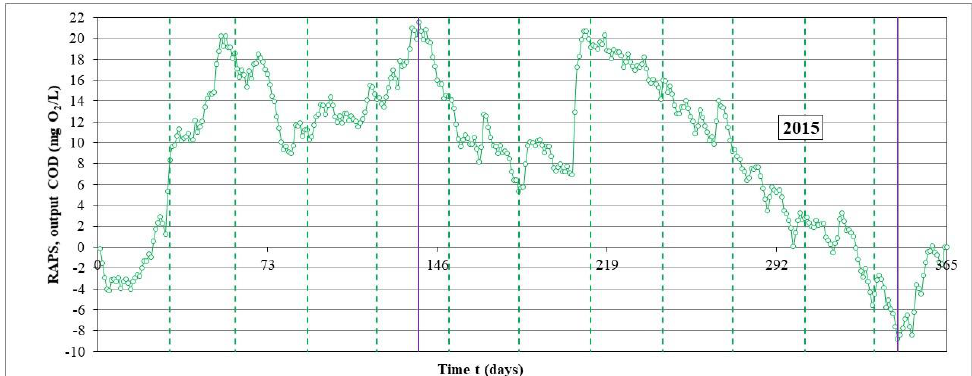
Figure 6. RAPS of the output COD for year 2015.